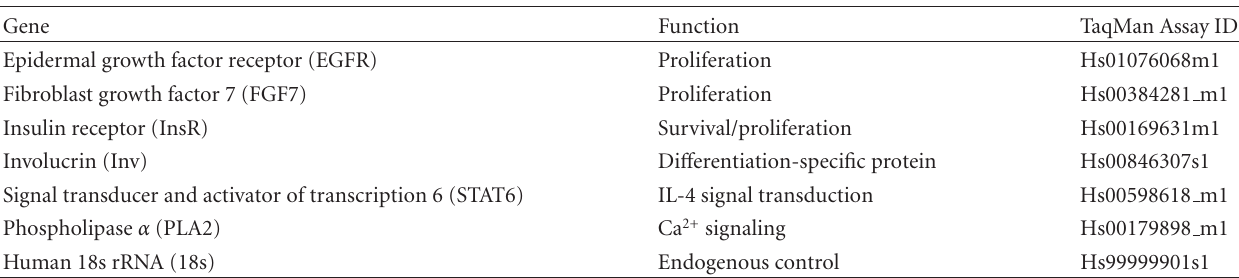
Table 1: TaqMan Assay IDs (Applied Biosystems, Foster City, USA) of specific proteins and representatives of signal pathways expressed in normal human fibroblasts (NHDFs) and normal human keratinocytes (NHEKs) investigated by real-time PCR after treatment